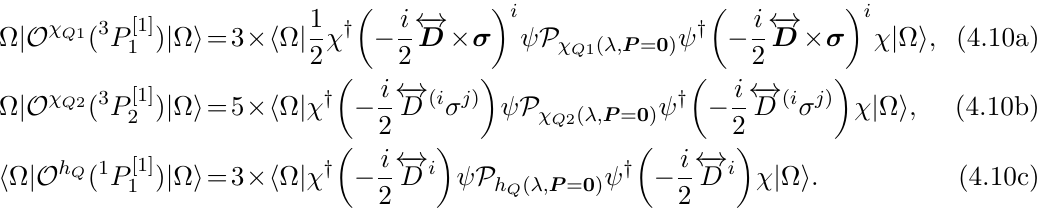
Figure 5 . Polarization of χ c 2 (1 P ) and χ c 1 (1 P ) at the LHC center of mass energy in the rapidity range | y | < 0 . 75 , averaged over the range 8 GeV < p J/ψ experimental constraints from CMS